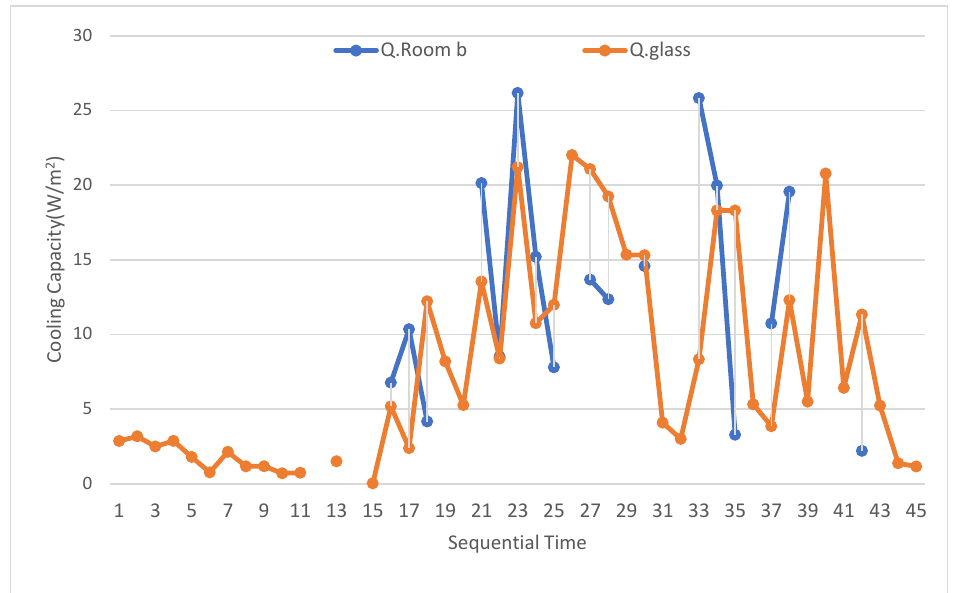
Figure 11. The cooling capacity of the passive intelligent radiant cooling system (7 August).